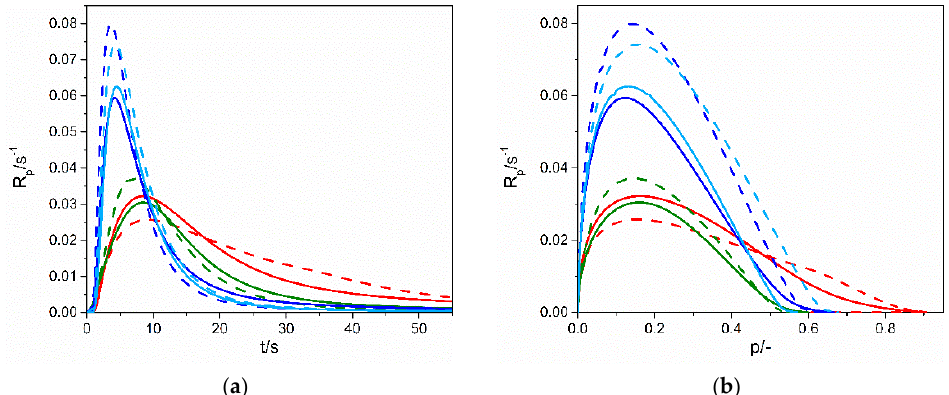
Figure 5. Dependence of polymerization rate (R p ) on ( a ) polymerization time (t) and ( b ) conversion (p) for PETMP – ene systems in bulk (solid lines) and in 70 wt.% of EMImNTf 2 (dashed lines). Used enes: DAP (red line), GBDA (green line), TAT (violet line), TATT (blue line).